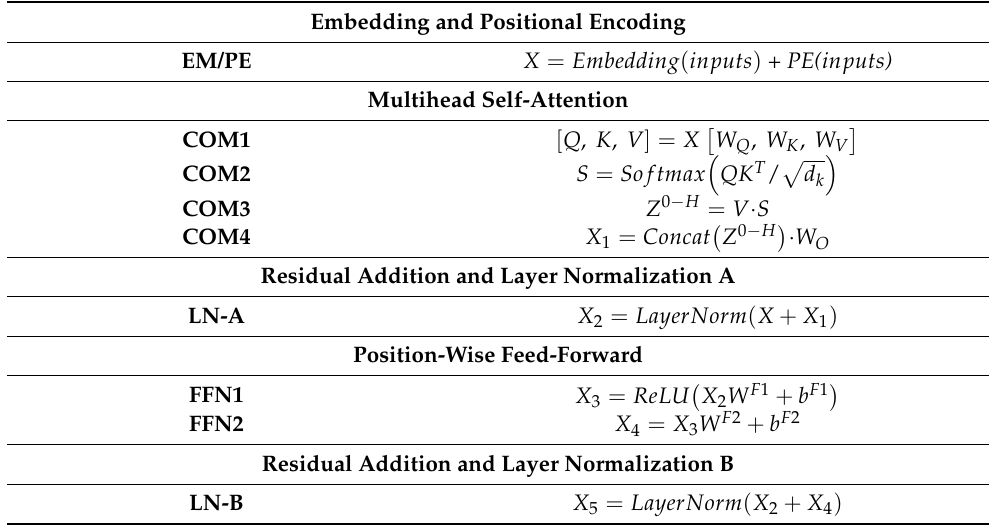
Table 1. Computation for the transformer’s encoder with H attention h eads.